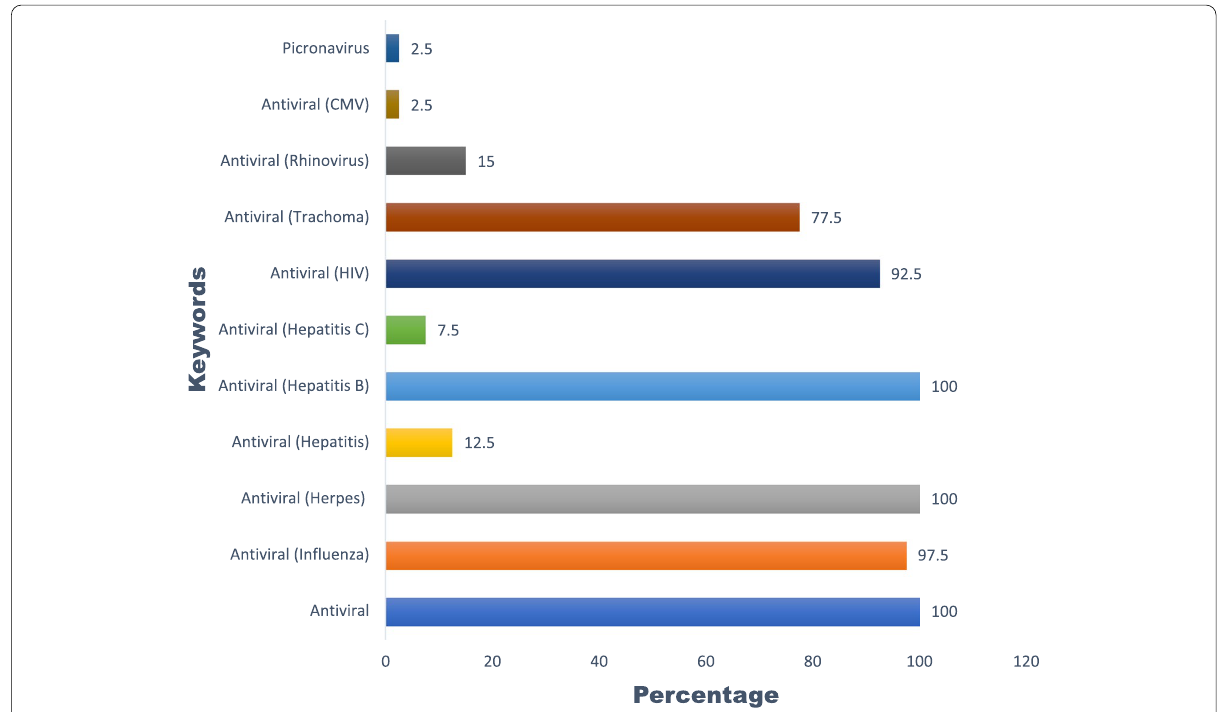
Fig. 4 Predicted antiviral activity of quercetin derivatives against multiple viruses